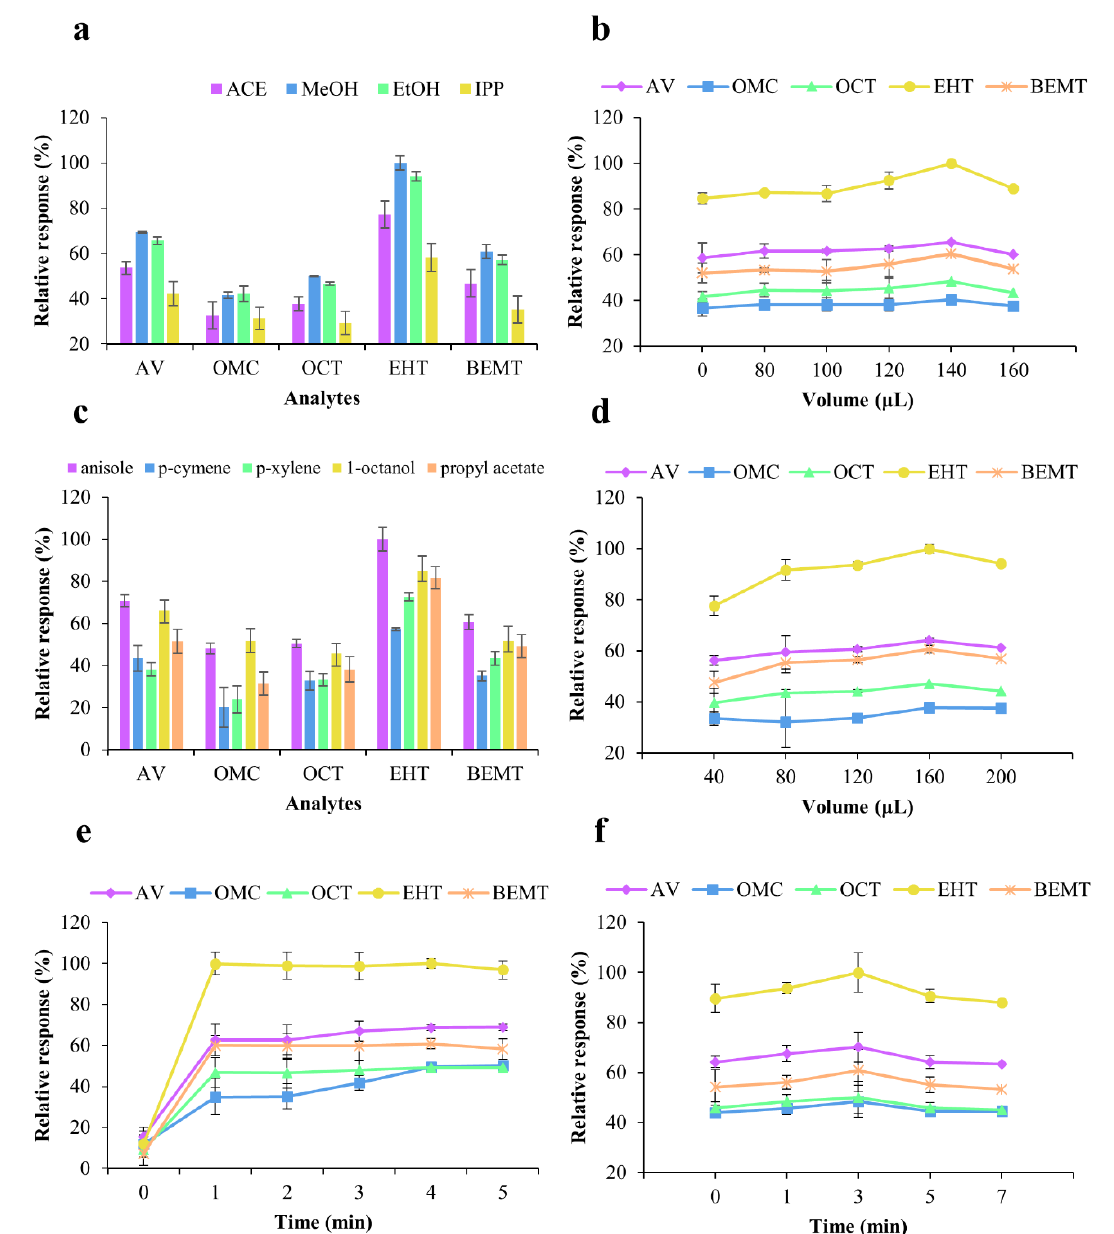
Figure 2. Effects of ( a ) dispersant, ( b ) dispersant volume, ( c ) extractant, ( d ) extractant volume, ( e ) vortexing time, and ( f ) ultrasonication time on the extraction efficiency of the US–VA–DLLME process.